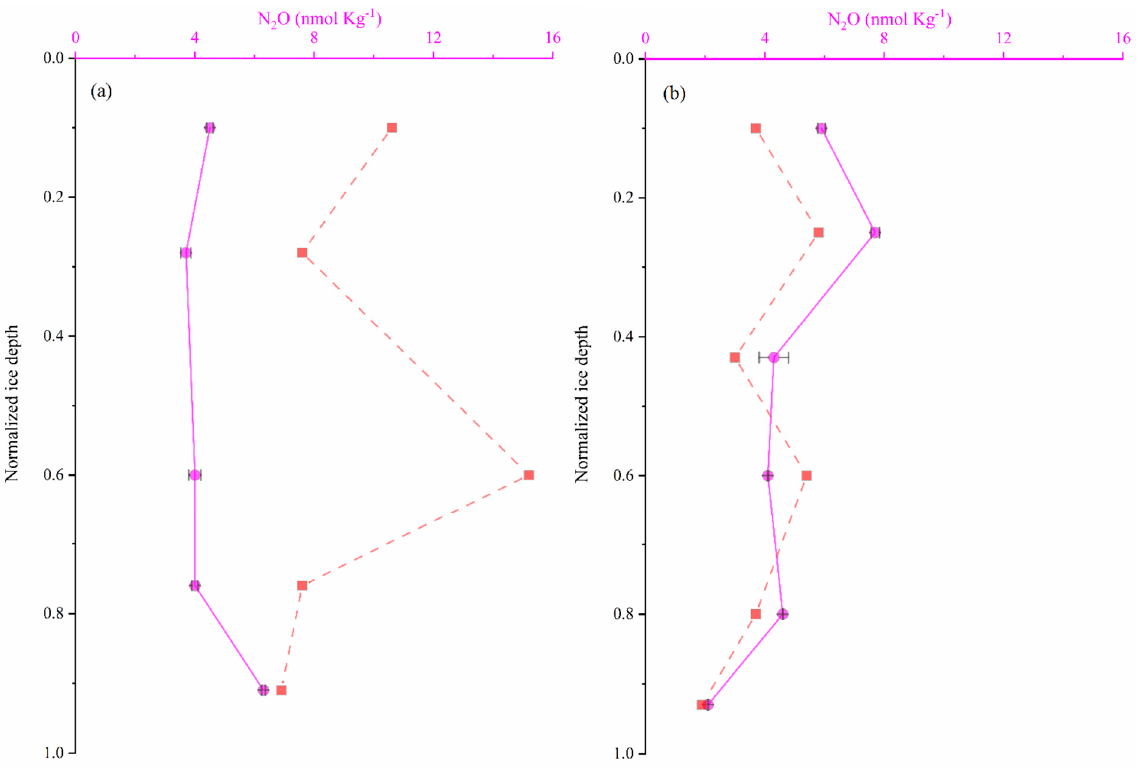
Figure 4. Sea ice observed N 2 O (claret line) and T-N 2 O ice (red line) concentration versus normalized depth for ( a ) FYI and ( b ) MYI.